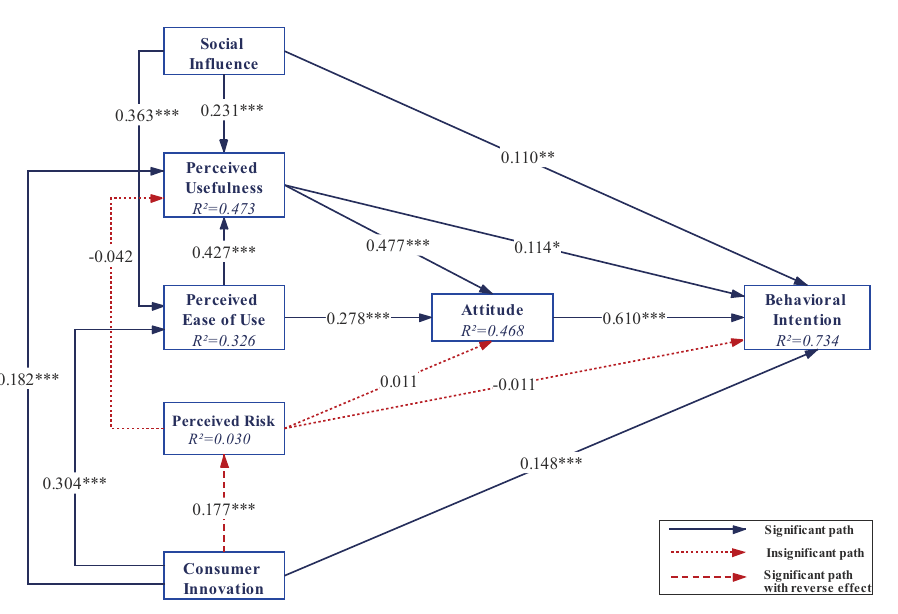
Figure 2. Structural model (*** p < 0.001, ** p < 0.01, * p < 0.05)